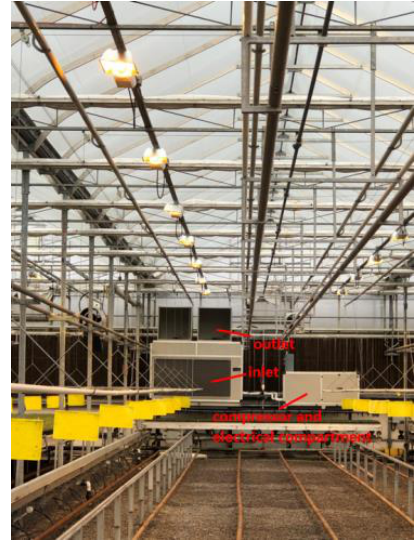
Figure A1. MRD in greenhouse bay.